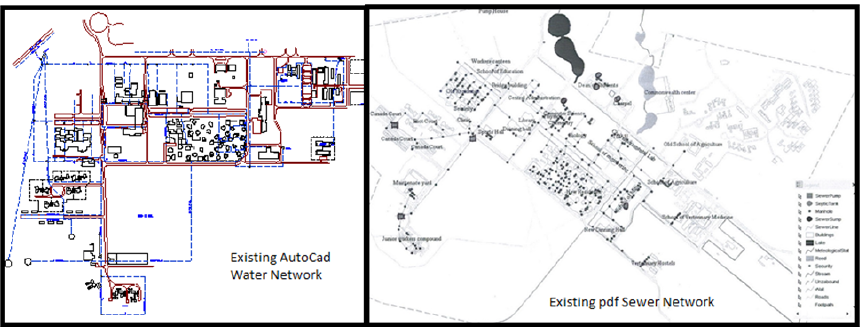
Fig. 3. Existing water network (AutoCAD Drawing) (left), Scanned Sewer Network